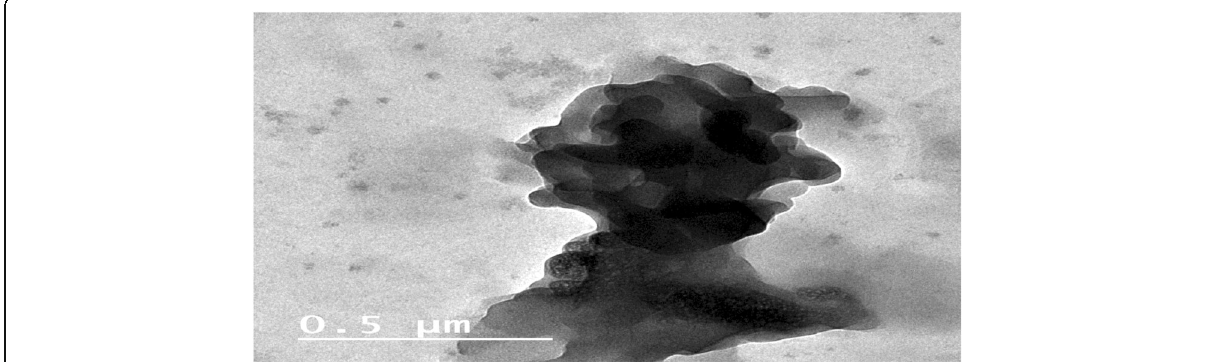
Fig. 3 Transmission electron microscopy (TEM) for spherical and granule morphology of zinc